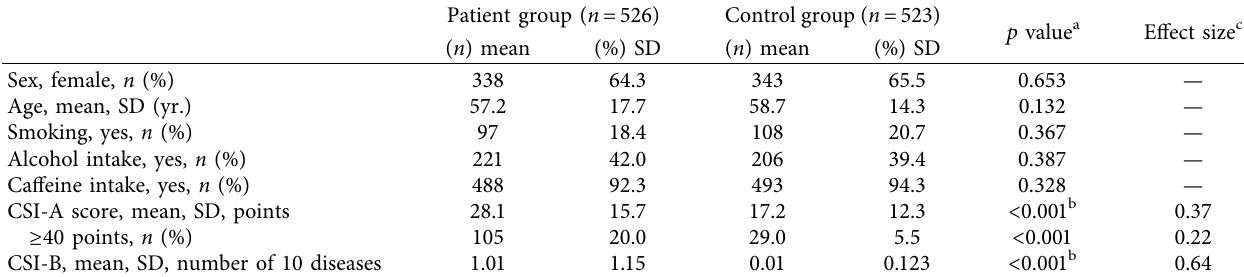
Table 2: Central Sensitization Inventory of the propensity score-matched patient and control groups.